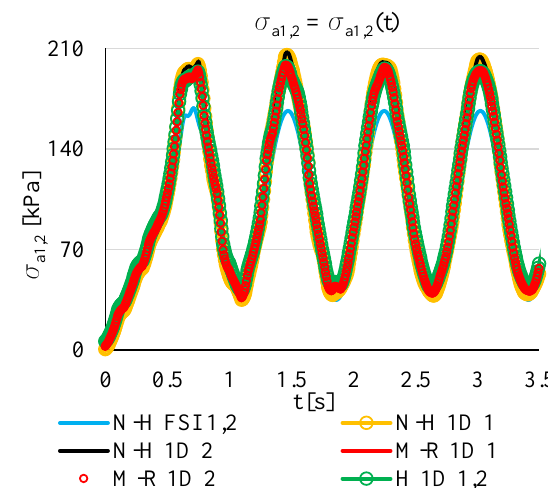
Fig. 15. Axial stresses σ a1 and σ a2 in thick-walled tube.